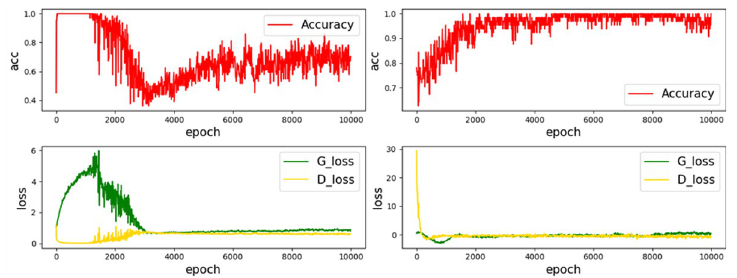
Fig 7. Original SRGAN and improved loss curve and accuracy curve. (a) SRGAN, (b) Our.